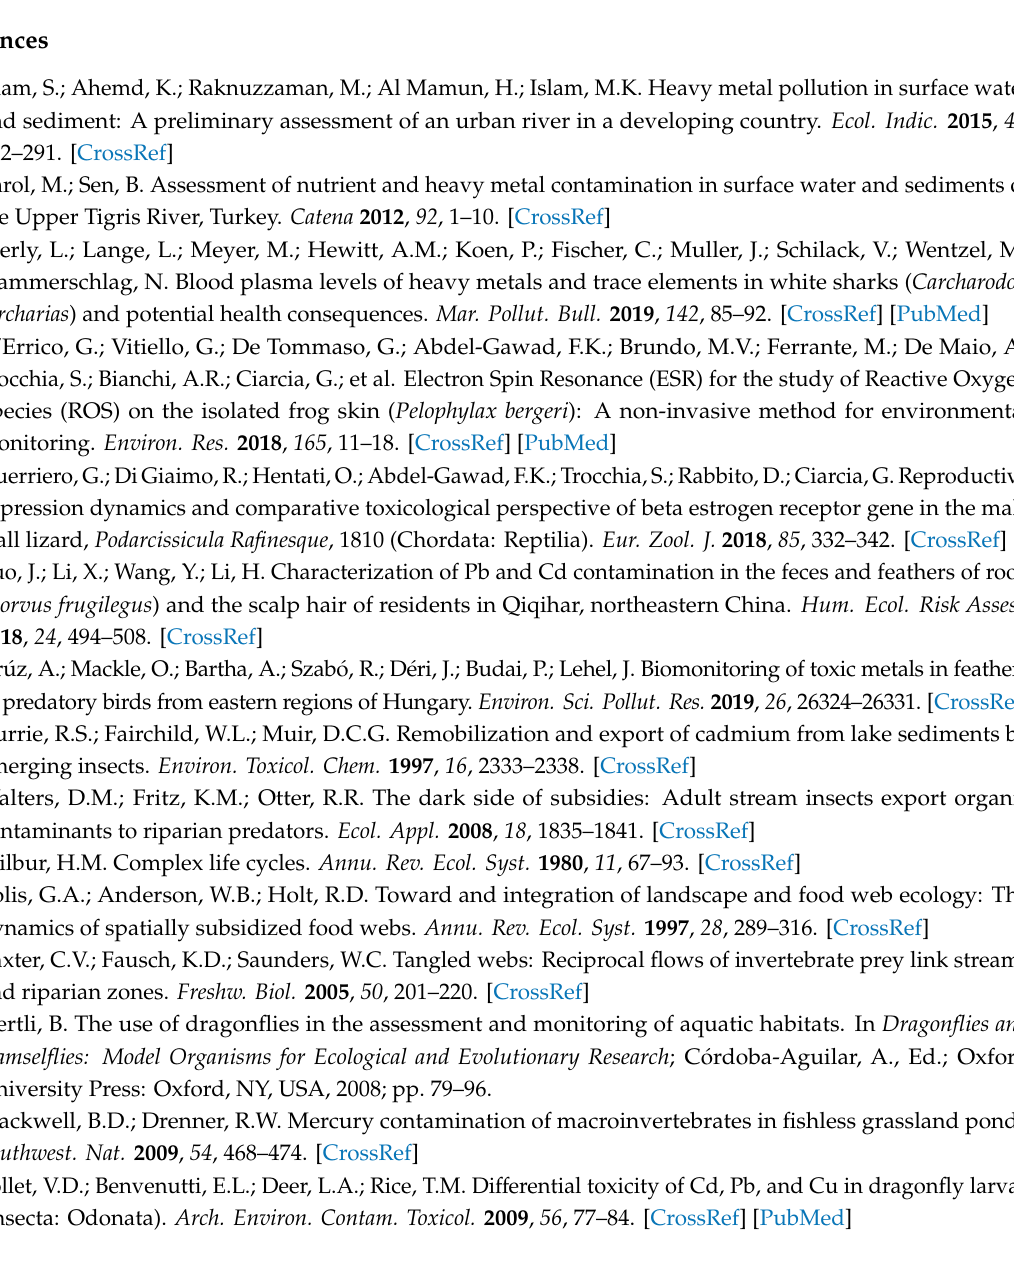
Table S1: Canonical discriminant analysis of element content per individual of di ff erent stages of G. flavipes in the Balsa studied area, Table S2: Canonical discriminant analysis of element content per individual of di ff erent stages of G. flavipes in the Tiszabercel studied area, Table S3: Canonical discriminant analysis of element content per individual of di ff erent stages of G. flavipes in the Tiszafüred studied area, Table S4: Canonical discriminant analysis of element content per individual of di ff erent stages of G. flavipes in the Tuzs é r studied area, Table S5: Results of non-parametric Kruskal–Wallis H test based on the element content per individual of di ff erent stages of G. flavipes . Author Contributions: Sample collection, O.K., P. É .S., T.J. and A.V.; sample preparation and elemental